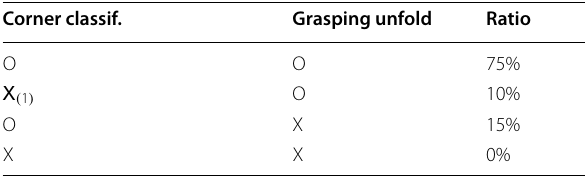
(1) Corner classification was correct in 85.72% of the steps An “X” in a cell means the operation in that column was not successful, whereas a circle indicates success. The ratio indicates the percentage of attempts with that particular corner classification and unfolding outcome